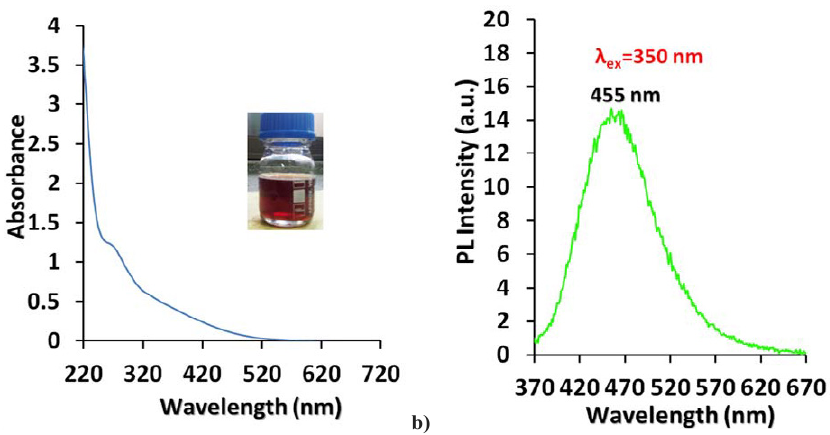
Fig. 5. Fig. 5. (a) Absorption (b) photoluminescence spectra of the colloidal germanium